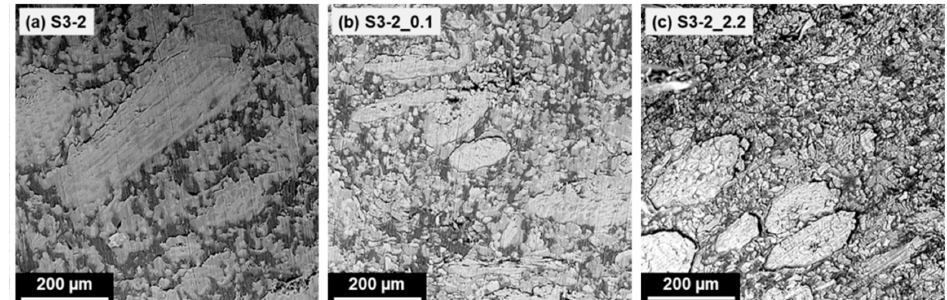
Figure 6. SEM images of the formulations prepared in Series 3. Brightest areas—wood particles (large particles, approximately 200–500 µ m in length) and cellulose fibres (small, roughly circular to elliptical shapes, approximately 15 µ m in diameter); light grey areas (slightly darker than fillers)—novolac-based phase; dark areas—LDPE. Mowital and Naftosafe cannot be distinctly identified in the SEM